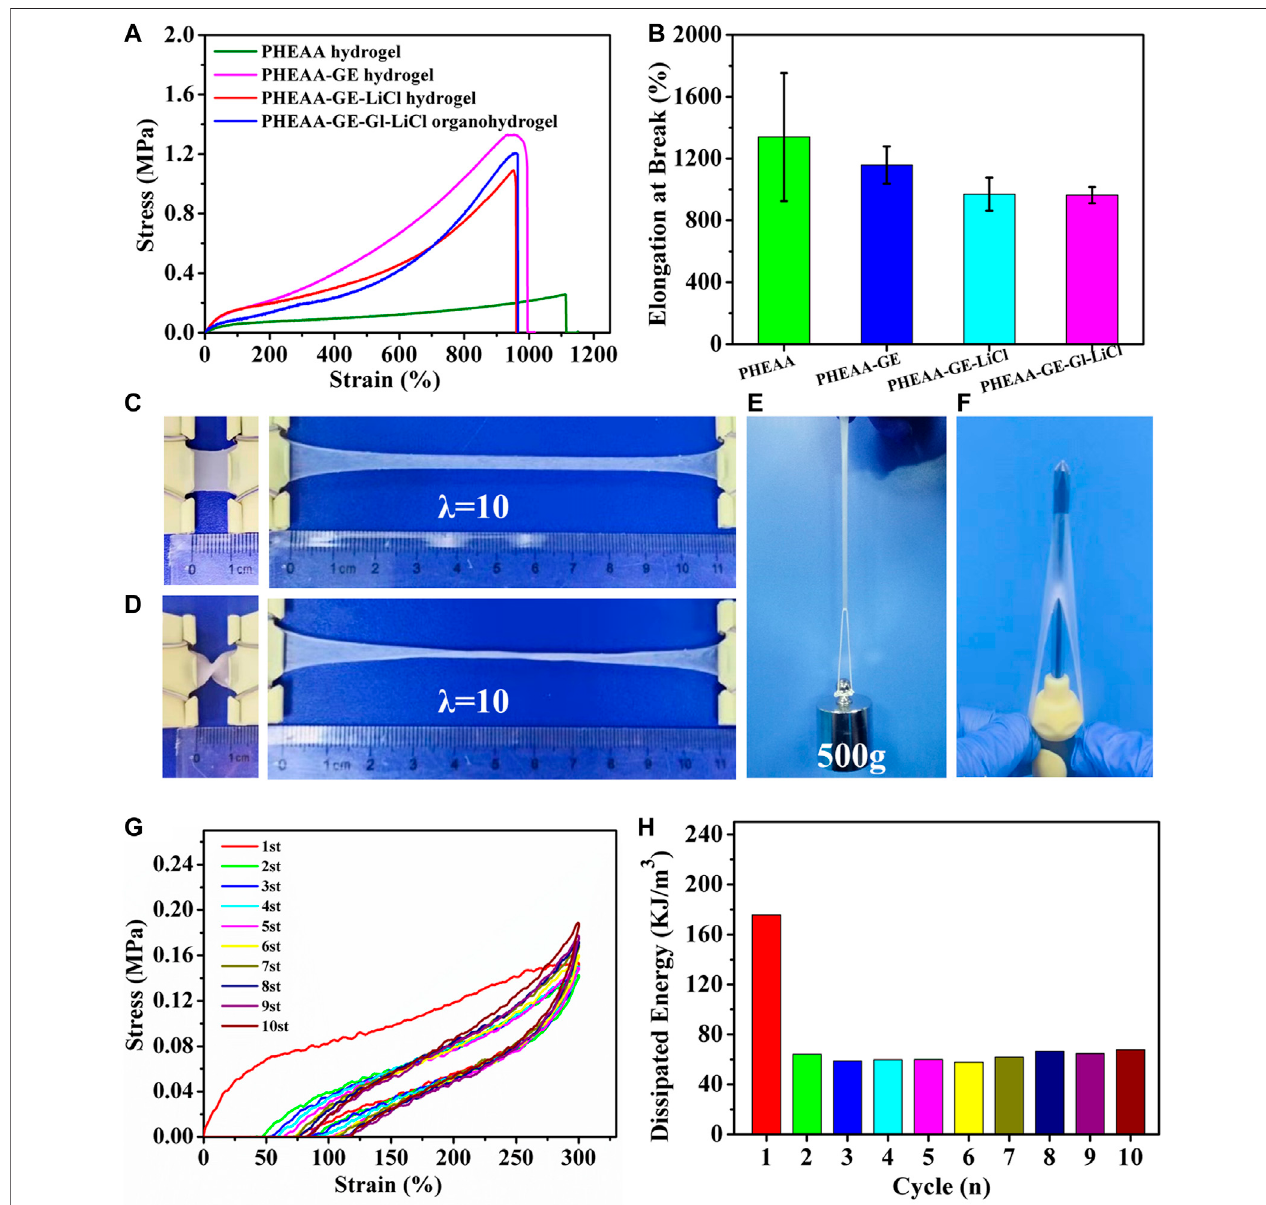
FIGURE2| ThemechanicalpropertyofPHEAA-GE-Gl-LiClDNorganohydrogel. (A) Thetypicaltensilestress-straincurvesofPHEAAhydrogel(C PHEAA (cid:1) 40 wt%), PHEAA-GE hydrogel (C PHEAA (cid:1) 36 wt%, C GE (cid:1) 4 wt%), PHEAA-GE-LiCl hydrogel (C PHEAA (cid:1) 36 wt%, C GE (cid:1) 4 wt%, C LiCl (cid:1) 1.2 wt%), PHEAA-GE-Gl-LiCl DN organohydrogel[C PHEAA (cid:1) 36 wt%,C GE (cid:1) 4 wt%,C LiCl (cid:1) 1.2 wt%,andGl:water(w/w) (cid:1) 1:3],and (B) theircorrespondingelongationsatbreak.PhotosofPHEAA-GE-Gl- LiCl DN organohydrogel at different states of (C) stretching, (D) curly stretching, (E) sustaining a weight of 500 g and (F) puncture resistance. (G) Ten continuous cyclic stretching and releasing process ofthe PHEAA-GE-Gl-LiCl organohydrogel under 300% tensile strain and (H) the correspondinghysteresis energy in every cycle.